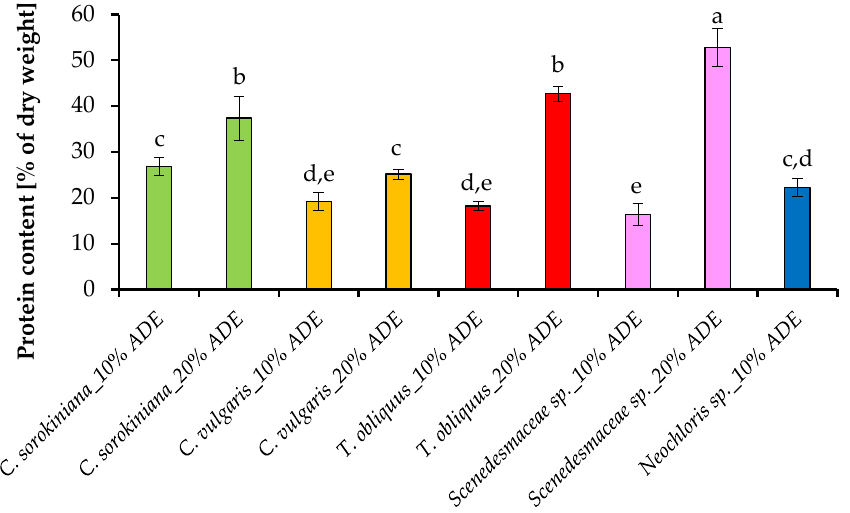
Figure 7. Protein content in algal cells cultured under different conditions. Means that do not share a letter are significantly different (ANOVA, Tukey method, α = 0.05).